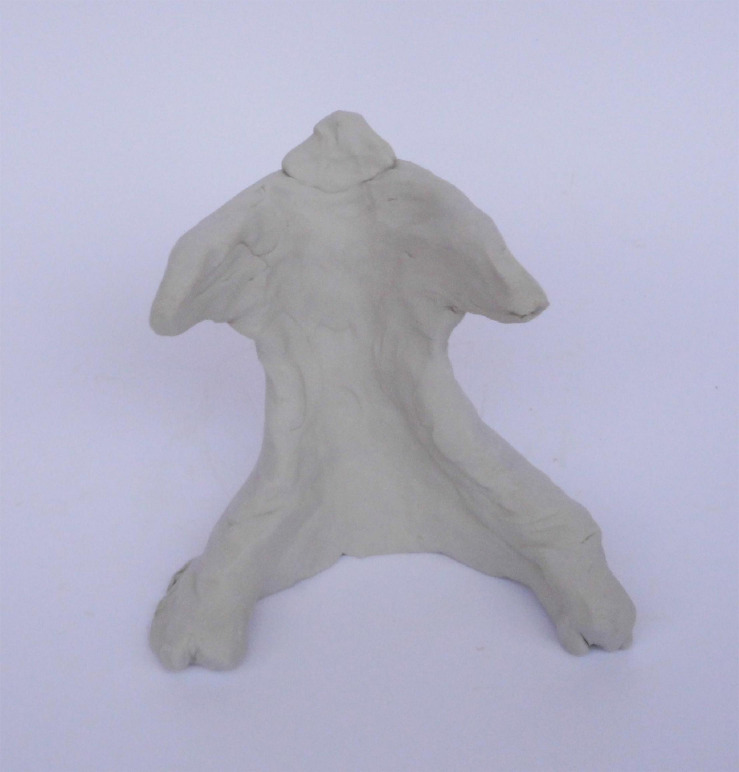
Roi’s sculpture.